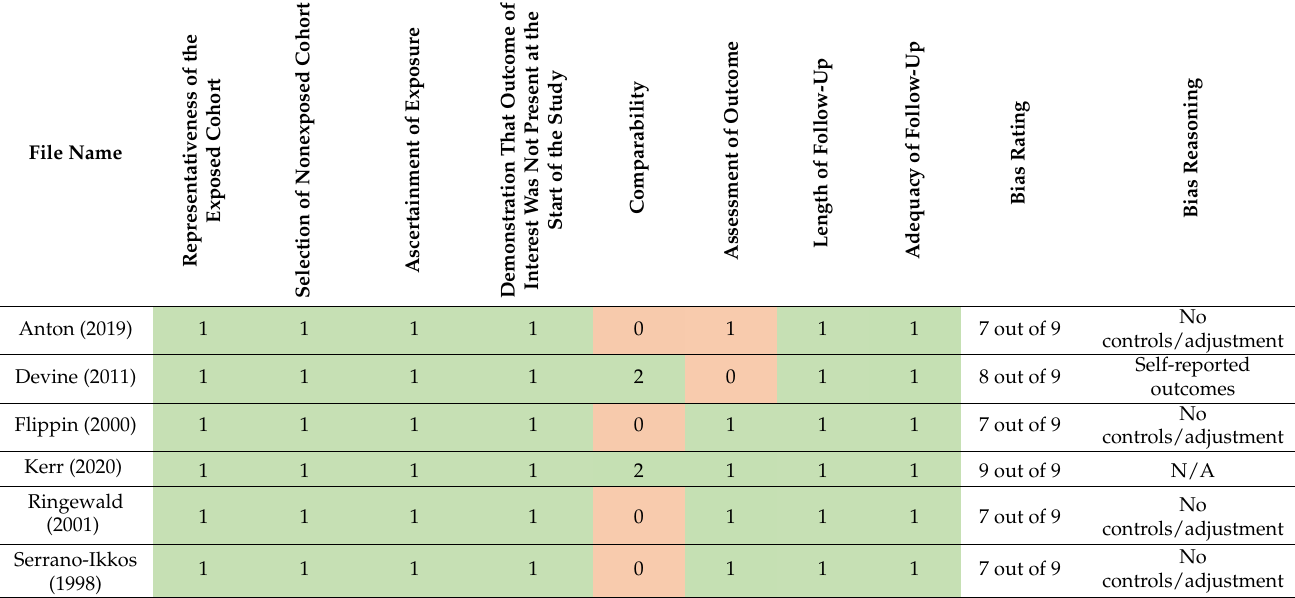
Table 6. Bias ratings of cohort studies via Newcastle–Ottawa